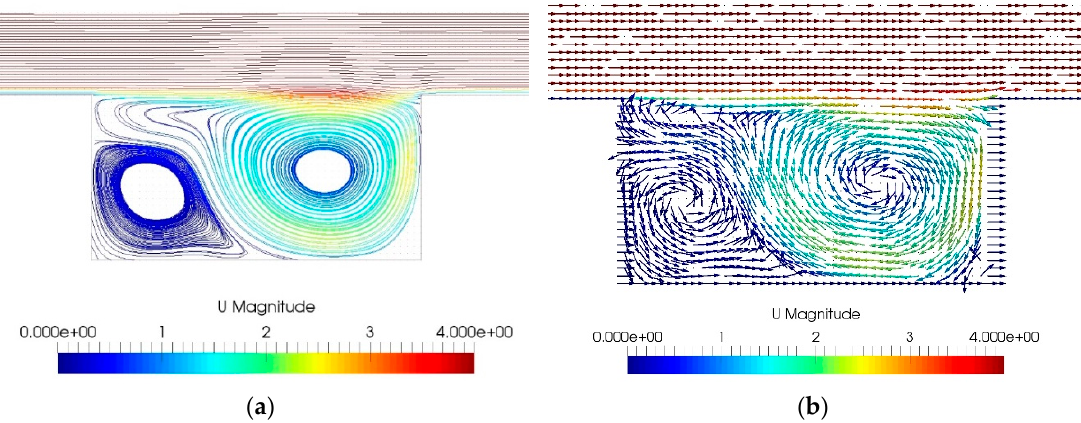
Figure 12. Streamline ( a ) and velocity vector ( b ) of wind flow inside the street canyons with AR =